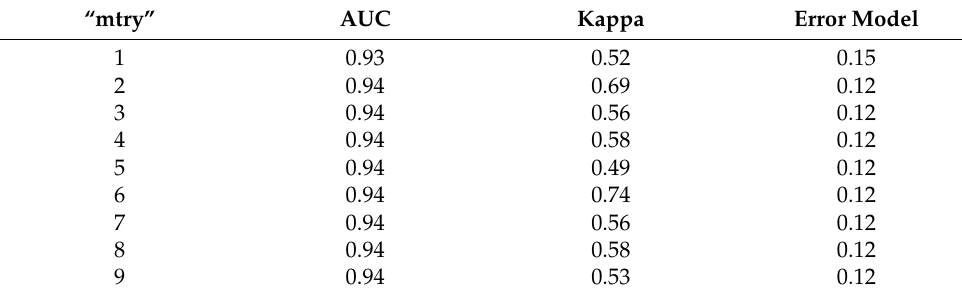
Table 2. AUC, kappa and error model of RFs.